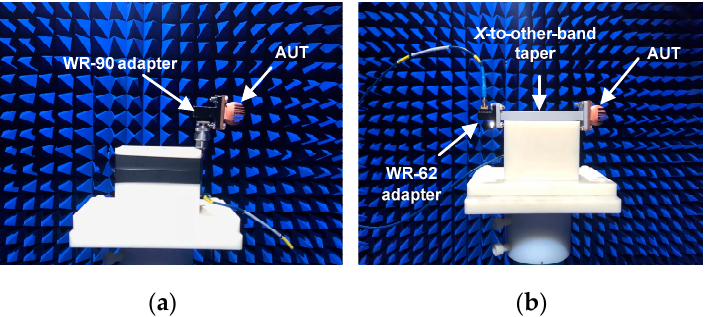
Figure 10. Photographs of the measured set-ups in the anechoic chamber: ( a ) in the measurement at the X band; ( b ) in the measurement at other bands.